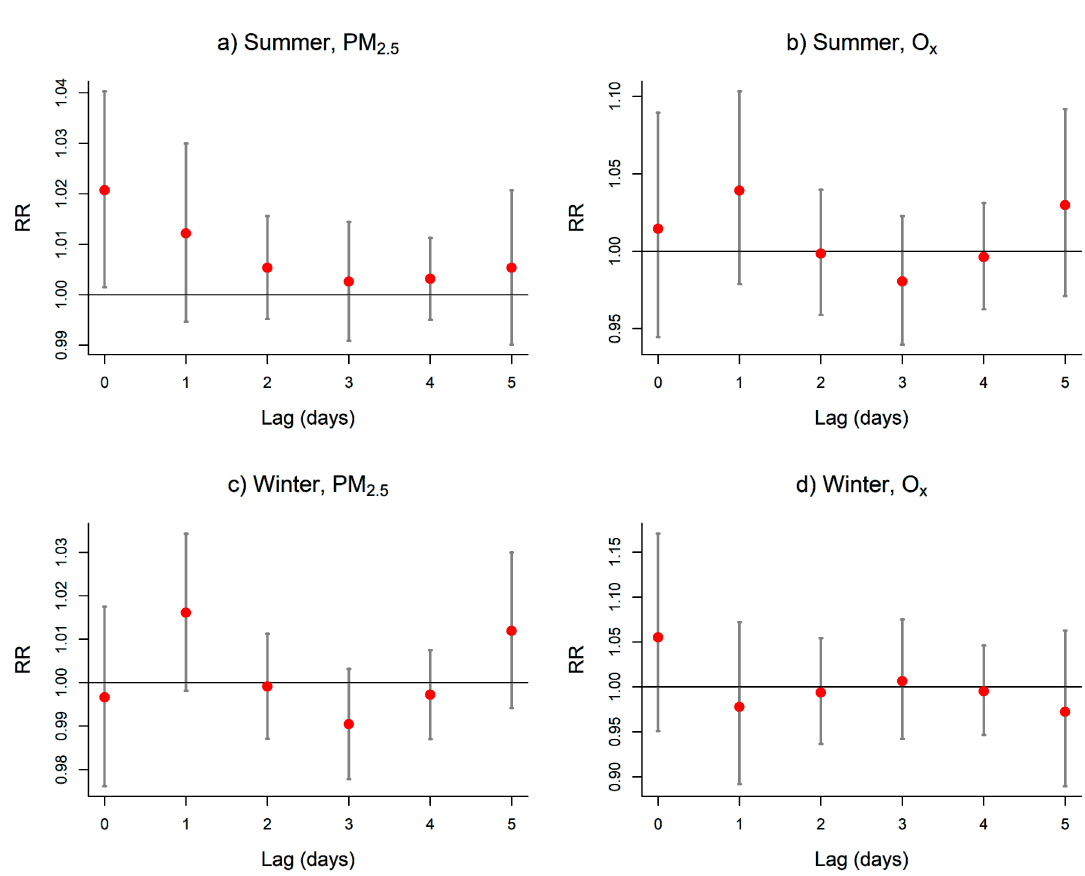
Figure 1. Lag–response relationship between mortality and ( a , c ) PM 2.5 and ( b , d ) O x in Montreal. These curves correspond to the slice of the distributed lag nonlinear model (DLNM) surface at values PM 2.5 = 25 µ g/m 3 and O x = 50 ppb. Gray bars indicate 95% confidence intervals. RR = relative risk.